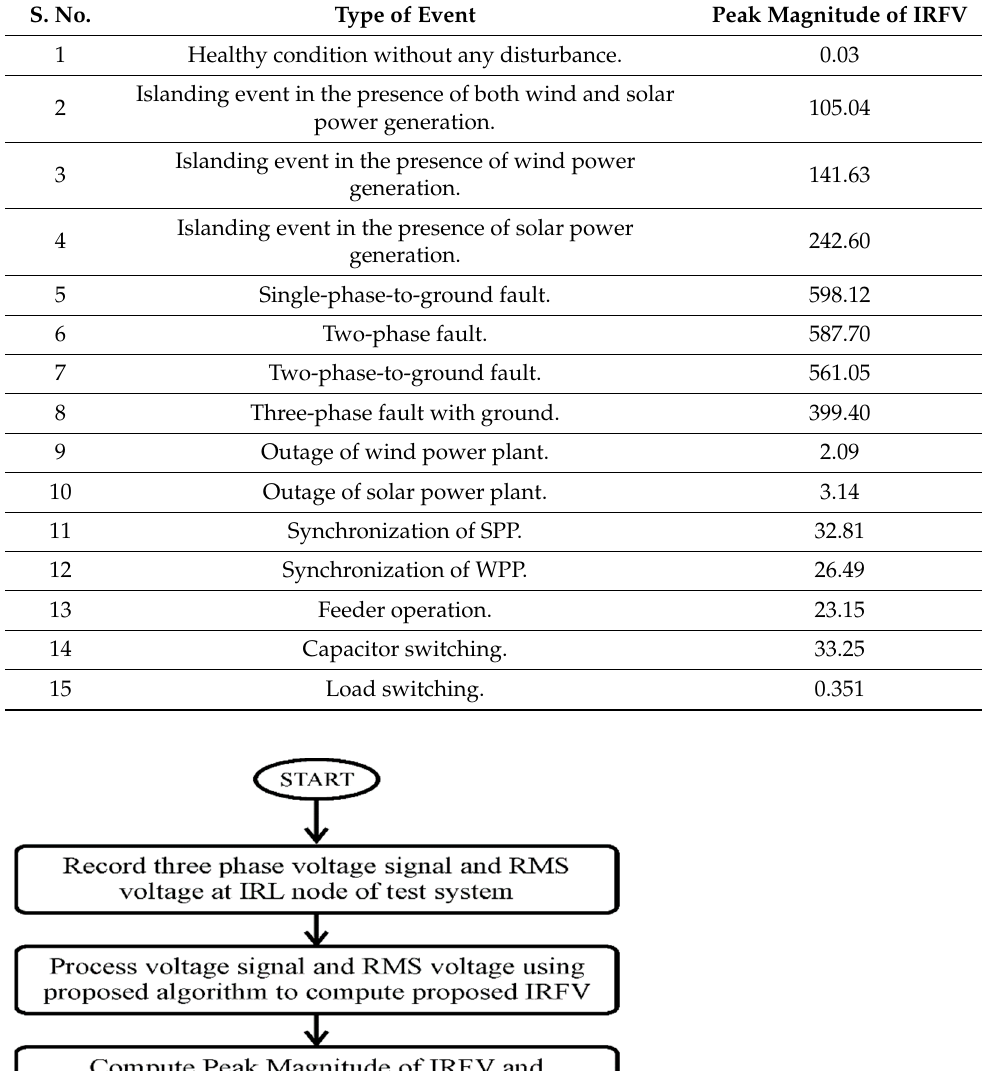
Table 4. Peak magnitude of voltage-based IRF.